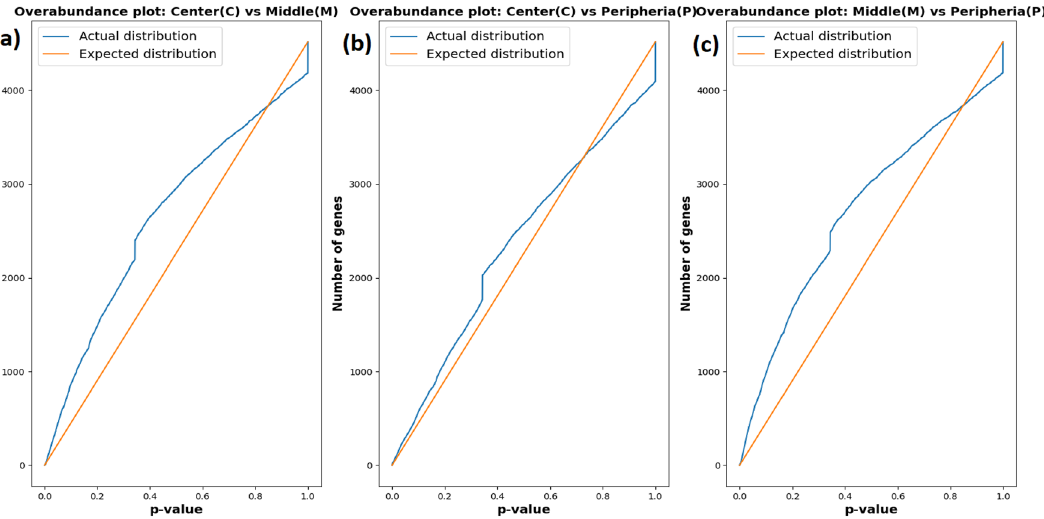
Figure 4. Overabundance plots comparing (“Methods” section) the distribution of the protein differential expression scores between 4T1 tumor locations. Total 5 mice and 4,519 proteins extracted by e-biopsy in 2 location replicas per sample were analyzed. ( a ) 4T1 center versus 4T1 periphery; ( b ) 4T1 center versus 4T1 middle; ( c ) 4T1 middle versus 4T1